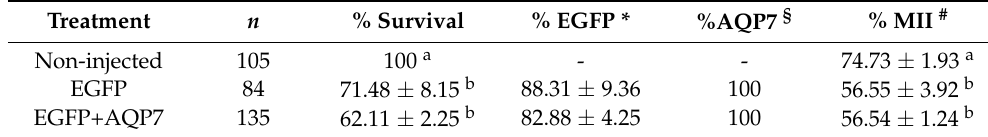
Table 2. Effect of EGFP cRNA injection alone or together with AQP7 cRNA on the survival rate, protein expression and maturation rate at 24 of IVM. Treatment n